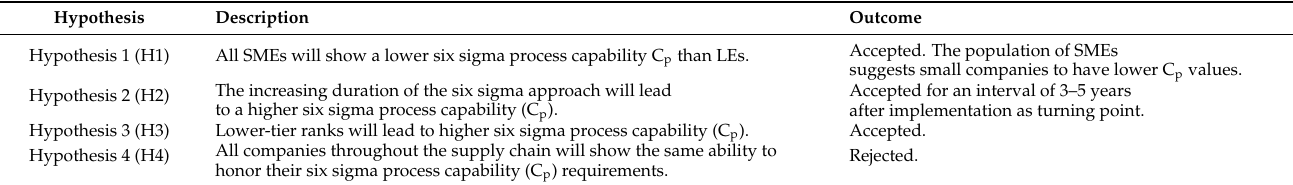
Table 6. Hypotheses’ summary and